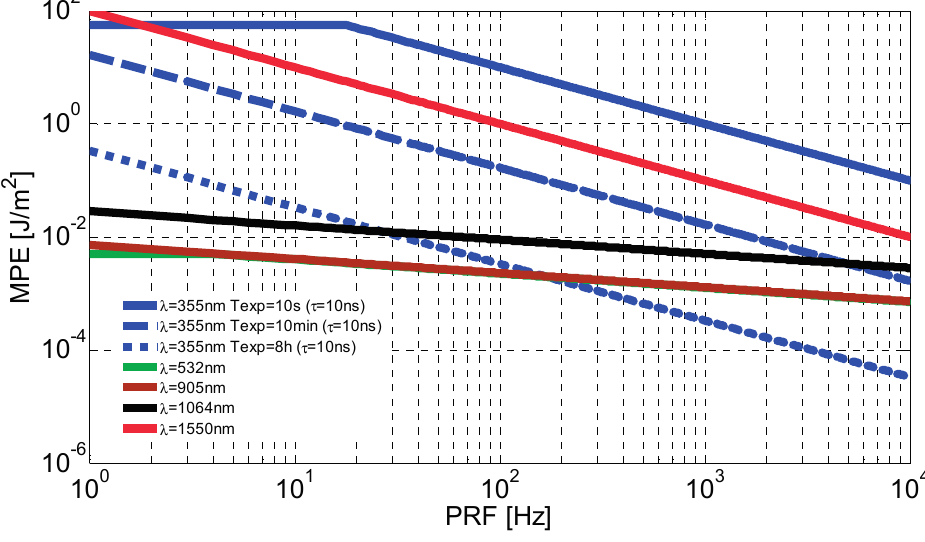
Figure 1. MPE for an individual pulse vs. pulse repetition frequency